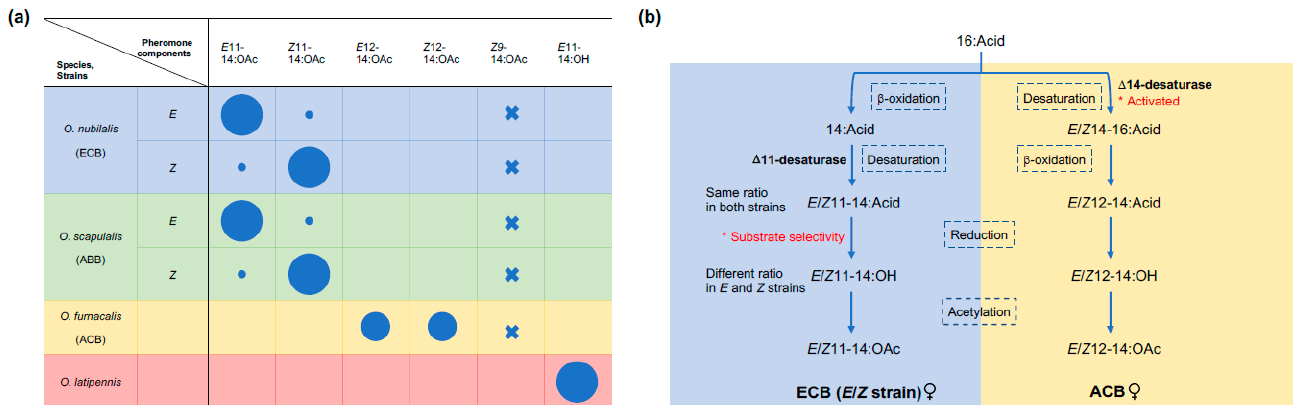
Figure 2. The pheromone composition ( a ) and biosynthetic pathway ( b ) in Ostrinia moths. The size of circles in ( a ) roughly correspond to the blend ratio, and the crossings represent behavioural antagonist. The key steps in the pathway that cause the shift in the pheromone composition are highlighted with asterisks in ( b